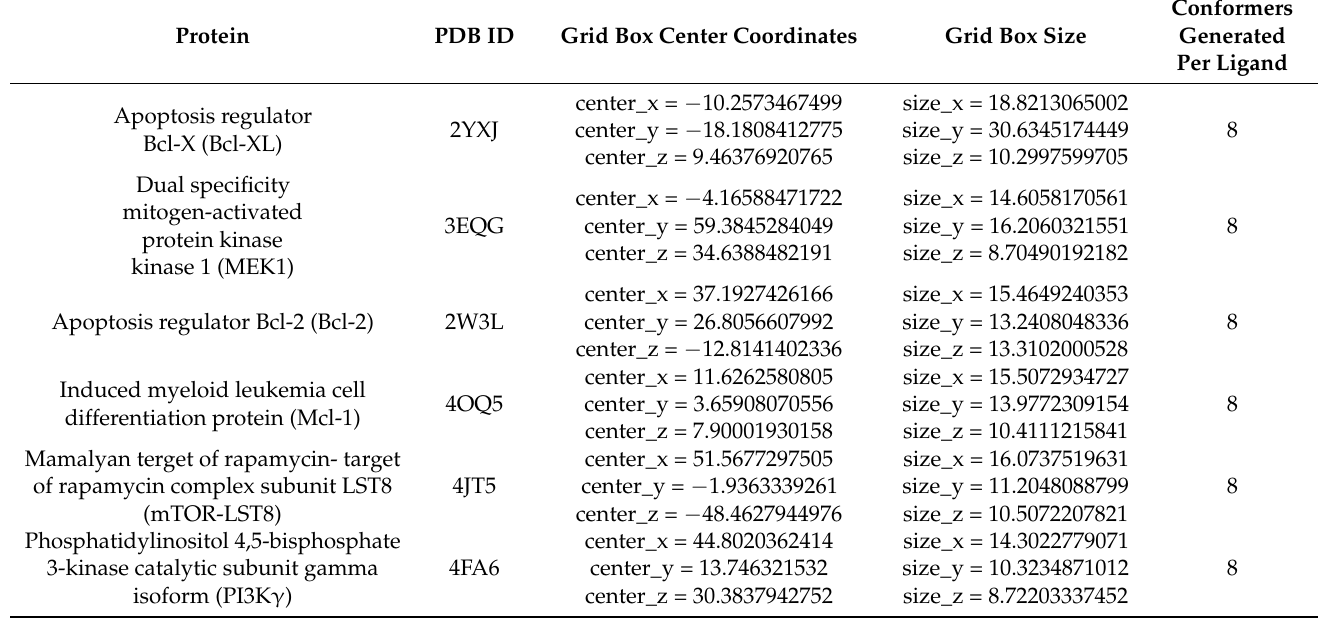
Table 7. Molecular docking parameters and protein